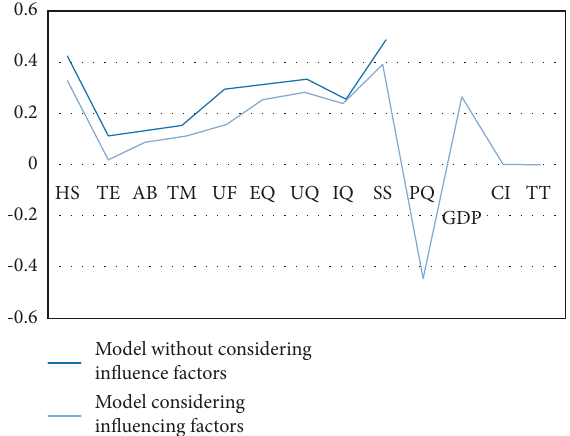
Figure 4: Calculation results of influence level of efficiency factors in symbiotic of high-tech industrial innovation